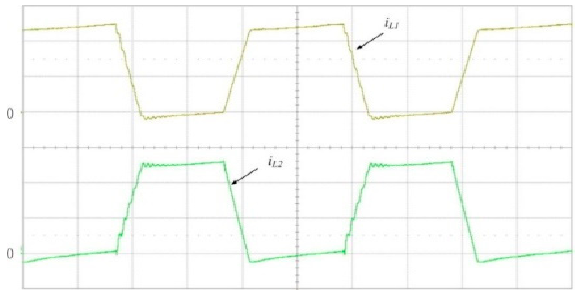
Figure 8. Current waveforms of i L 1 and i L 2 . ( i L 1 , i L 2 : 2 A / div, time: 5 µ s / div)